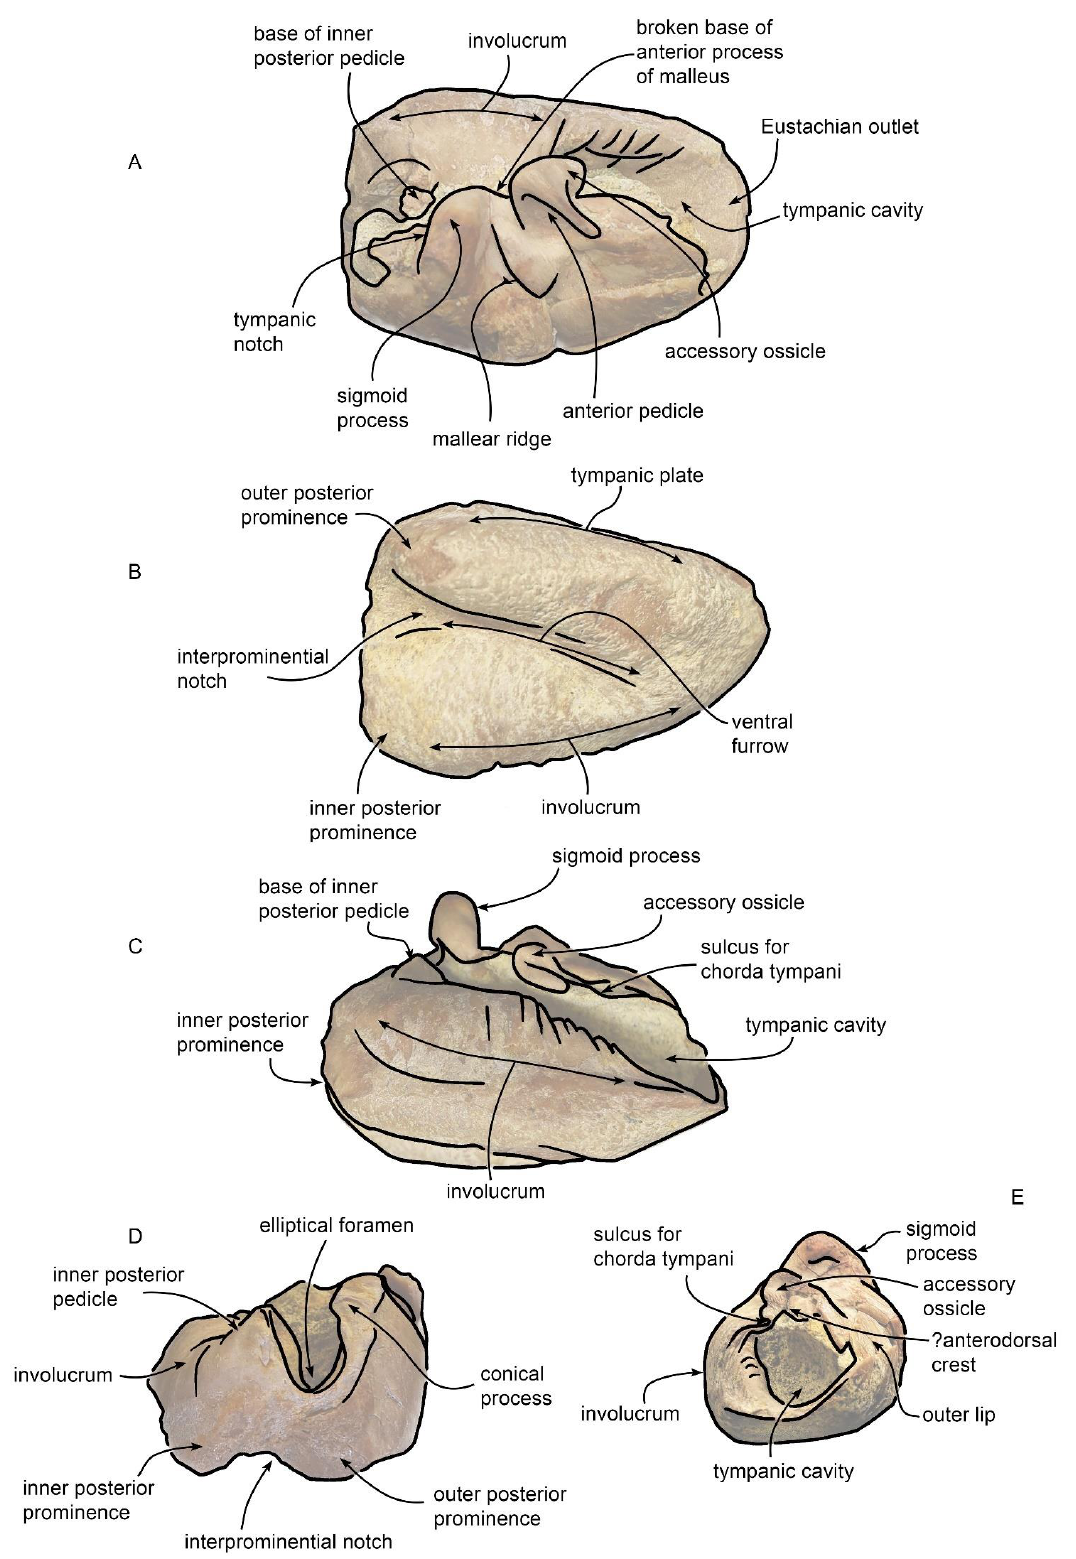
Figure 10. Anatomical interpretation of characters observed in the tympanic bullae MGPT-PU 13881/2 and 13906. Not to scale. ( A ) dorsal view. ( B ) ventral view. ( C ) medial view. ( D ), posterior view. ( E ) anterior view.